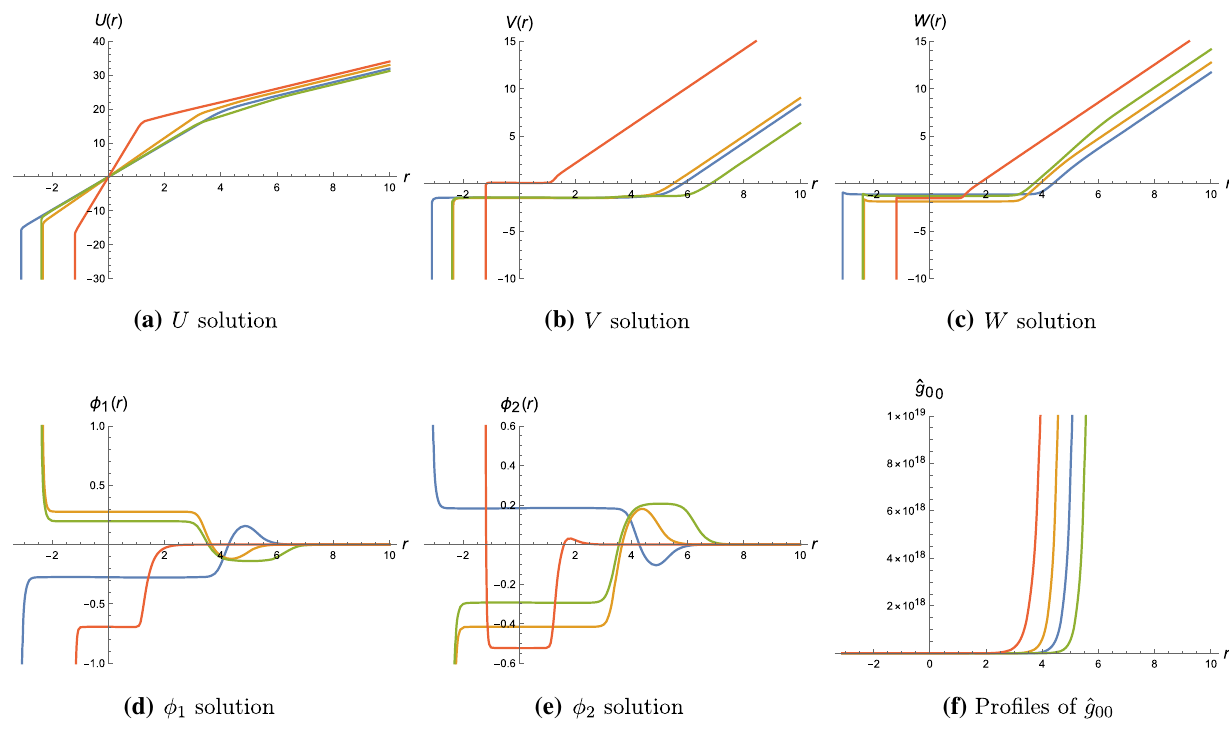
Fig. 16 RG flows from the N = 4 AdS 7 critical point to the AdS 3 × H 2 × S 2 fixed points and curved domain walls for SO ( 2 ) × SO ( 2 ) twist in SO ( 5 ) gauge group. The blue, orange, green and red curves refer to ( z 1 , z 2 ) = ( − 1 , 5 ),( 1 , − 2 ),( 1 , − 4 ),( − 3 , 8 ) , respectively